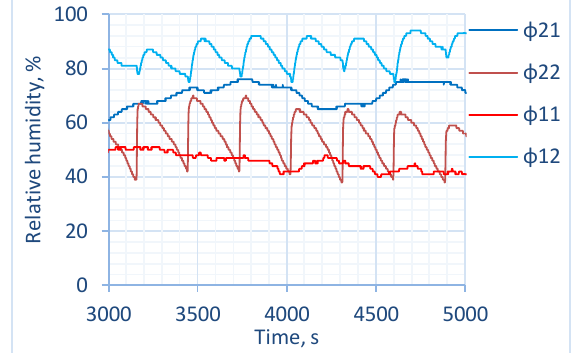
Fig. 4. Fresh 𝜑 21 , supply 𝜑 22 , exhaust 𝜑 11 and waste 𝜑 12 air relative humidity changes.